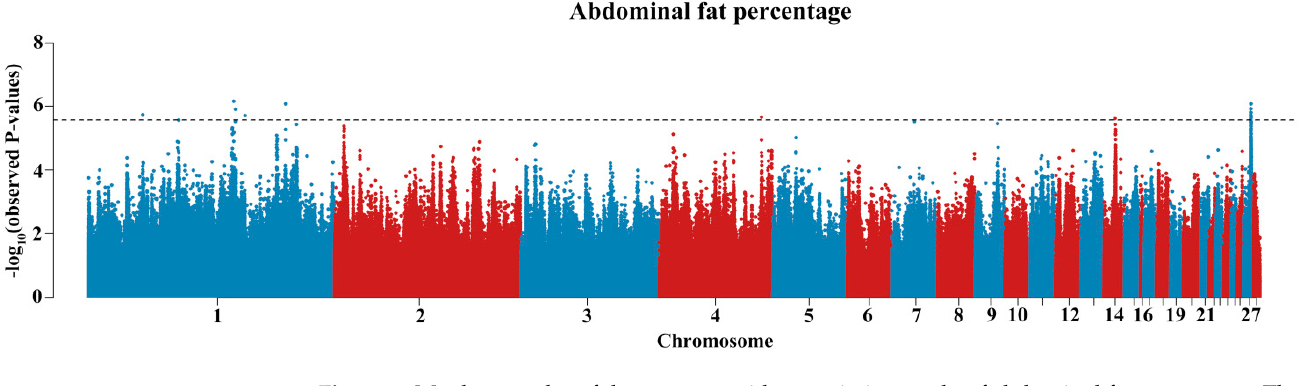
Figure 2. Manhattan plot of the genome-wide association study of abdominal fat percentage. The Manhattan plot indicates − log10 (observed p − values, y − axis) for genome-wide SNPs plotted against their respective locations on the genome. The horizontal red lines indicate the suggestive significant (2.64 × 10 − 6 ) thresholds.